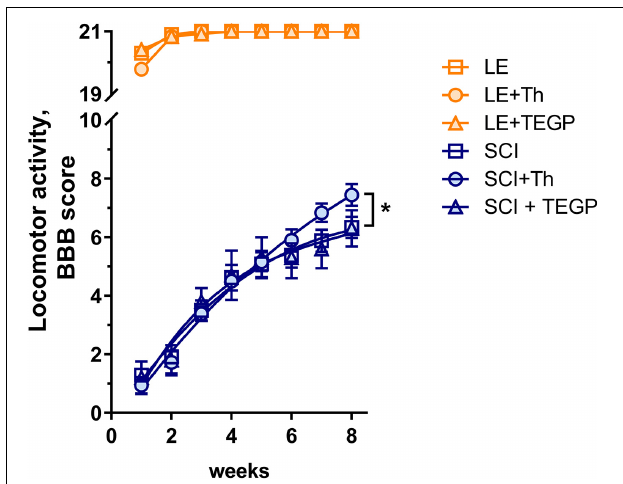
FIGURE 5 | Locomotor recovery during 8 weeks after SCI or LE in the non-treated rats and those with the post-operative administration of thiamine (Th) or TEGP. The recovery of locomotion is scored from 0 to 21 using the BBB scale (Basso et al., 1995). Number of animals in each group: LE, n = 5, LE + Th, n = 12, LE + TEGP, n = 6, SCI, n = 12, SCI + Th, n = 9, SCI + TEGP, n = 5. Data is fitted with the third order polynomial equation. Significance of the differences between the approximation curves is estimated by the extra sum-of-squares F -test. P -value < 0.05 is shown by